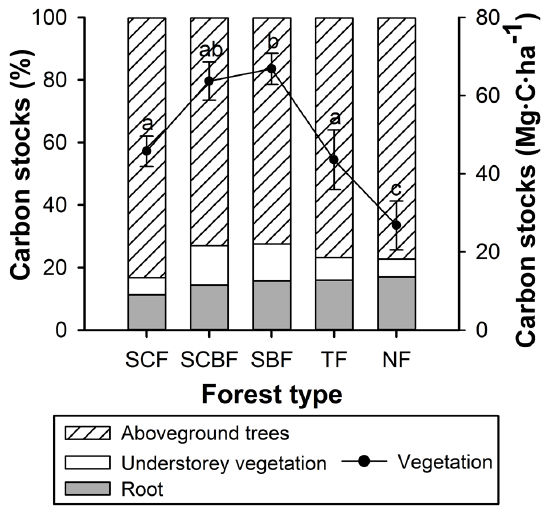
Figure 2. Vegetation biomass carbon pools in different forests. Different letters indicate significant differences across forest types (Student ‐ Newman ‐ Keuls (S ‐ N ‐ K) test, p < 0.05). Error bars denote standard errors.